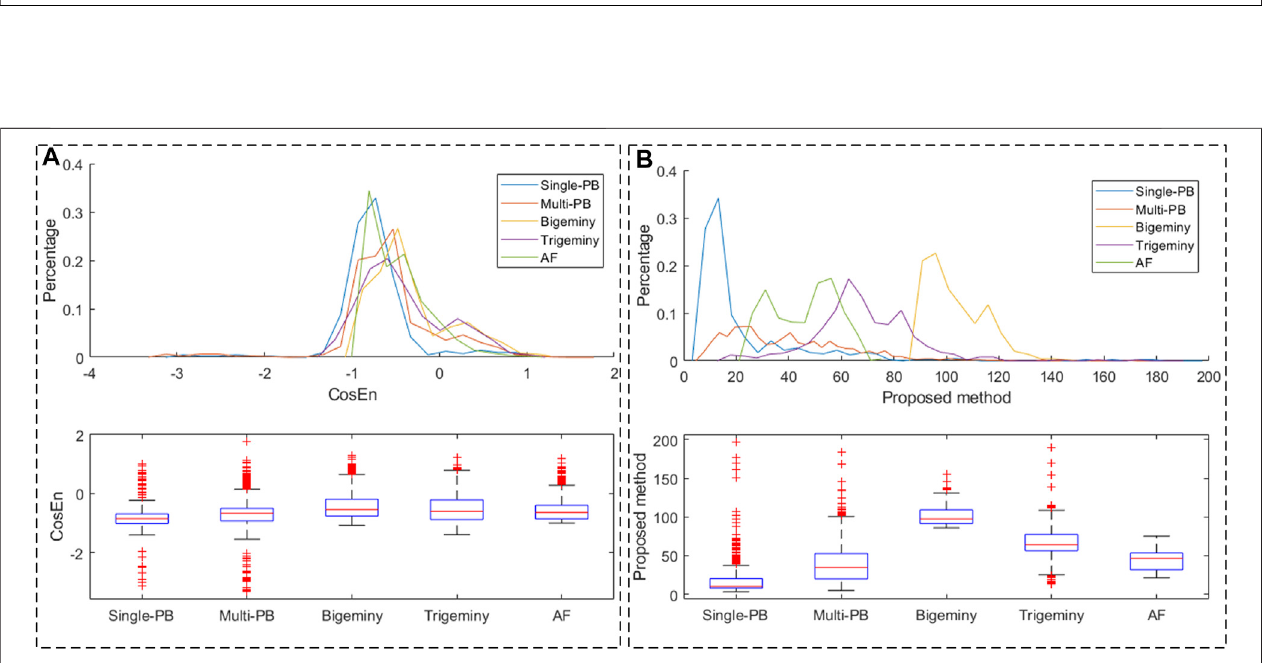
FIGURE 4 | The feature value distribution in ECG segments with PB and AF. (A) CosEn; (B) R c .